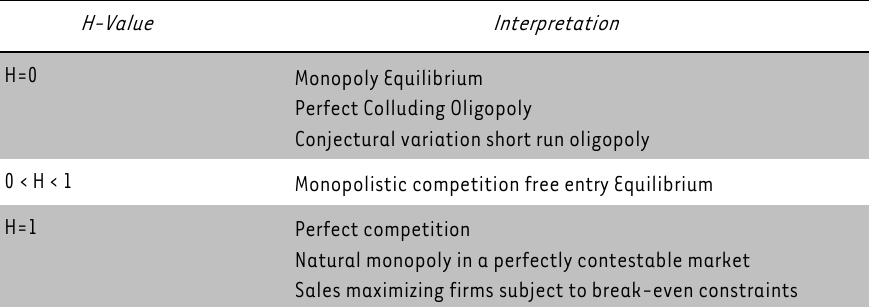
TABLE 2: H-Statistic